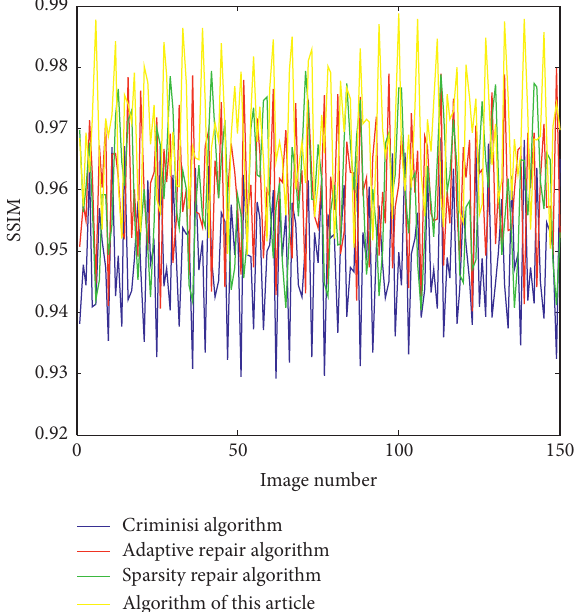
Figure 17: Comparison of structural similarity (SSIM) of various